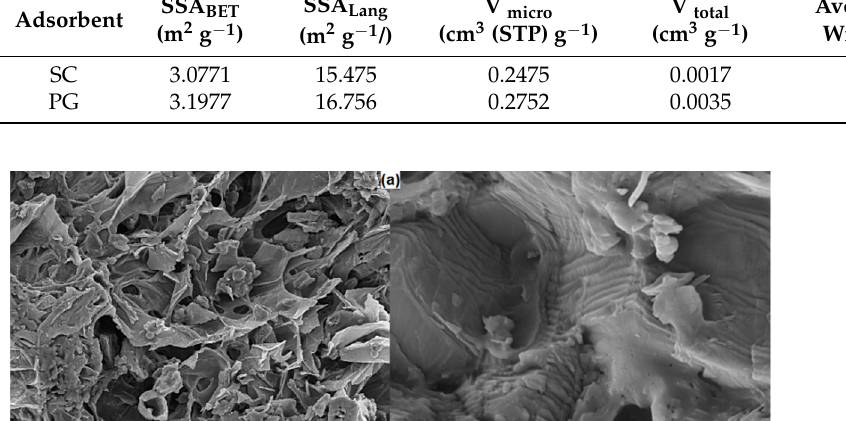
Table 2. Textural parameters of prepared biosorbents.